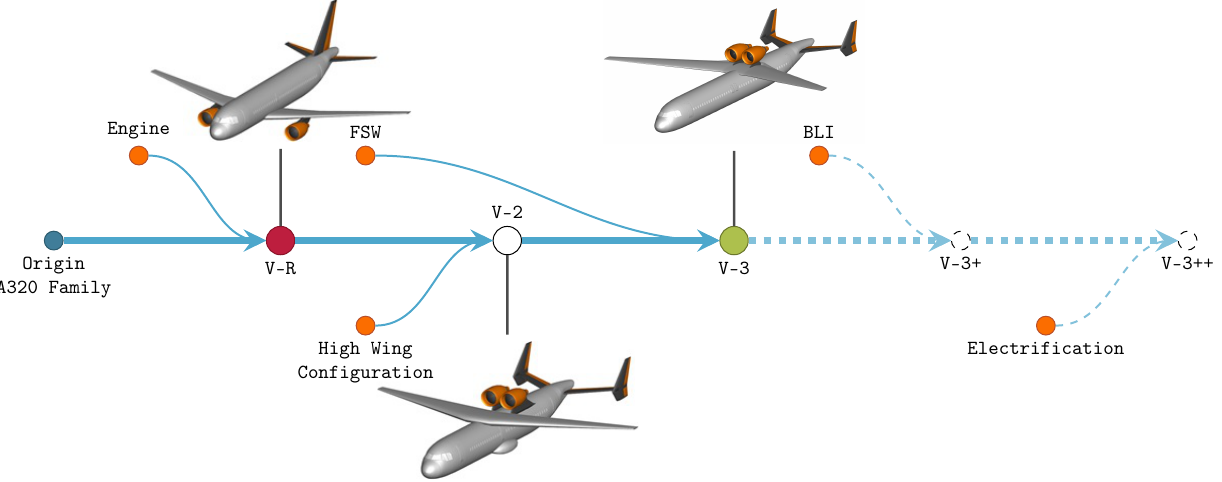
Figure 4. Evolution of low noise aircraft design at